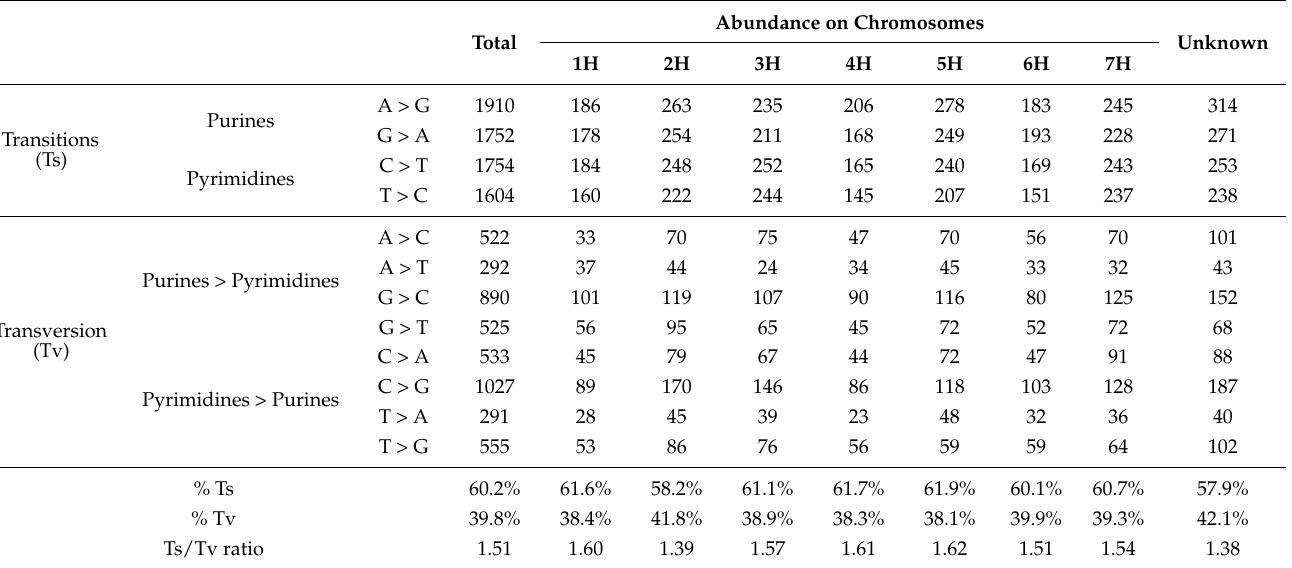
Table 2. Summary of point mutation abundance at the studied loci by chromosome based on DArTseq analysis of 83 spring barley